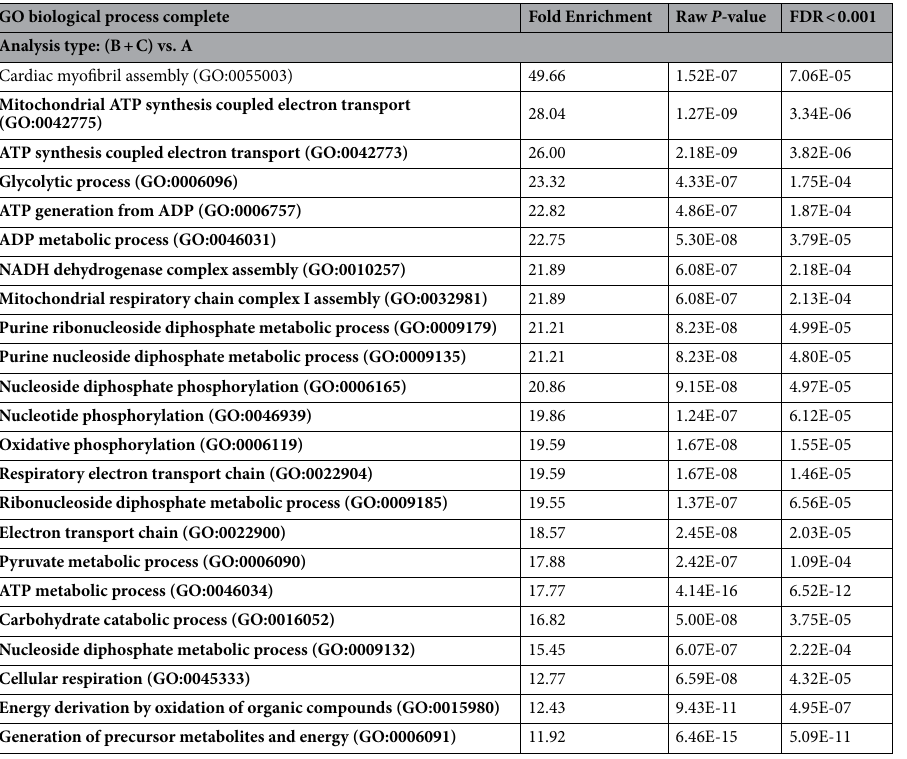
Table 2. Gene Ontology analysis of significantly altered biological processes in 2DG treated murine heart indicates altered glycolysis/carbohydrate metabolism, as well as augmented respiratory chain capacity. GO biological processes identified as significantly altered in murine heart by 2DG treatment combining the data from two groups treated with 2DG (B and C), vs. controls (A) (127 proteins). The peptide abundances were converted to log2 and a t-test applied and filtered, criteria for inclusion: FDR < 0.001; > tenfold enrichment. GO processes in bold relate to mitochondrial energy production and ATP metabolism, or glycolysis/carbohydrate